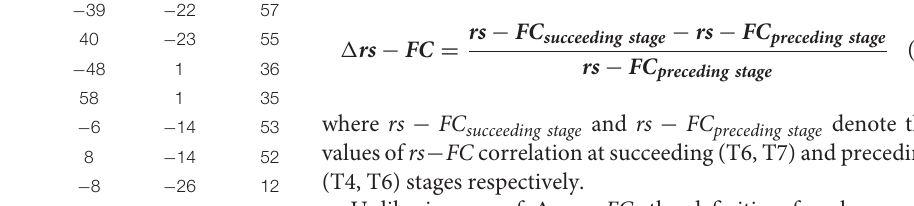
TABLE 3 | Shorthand representation of the eight ROIs in the motor network used for the analysis is presented below. ROI Shorthand X (MNI) Y (MNI) Z (MNI) Left primary motor cortex